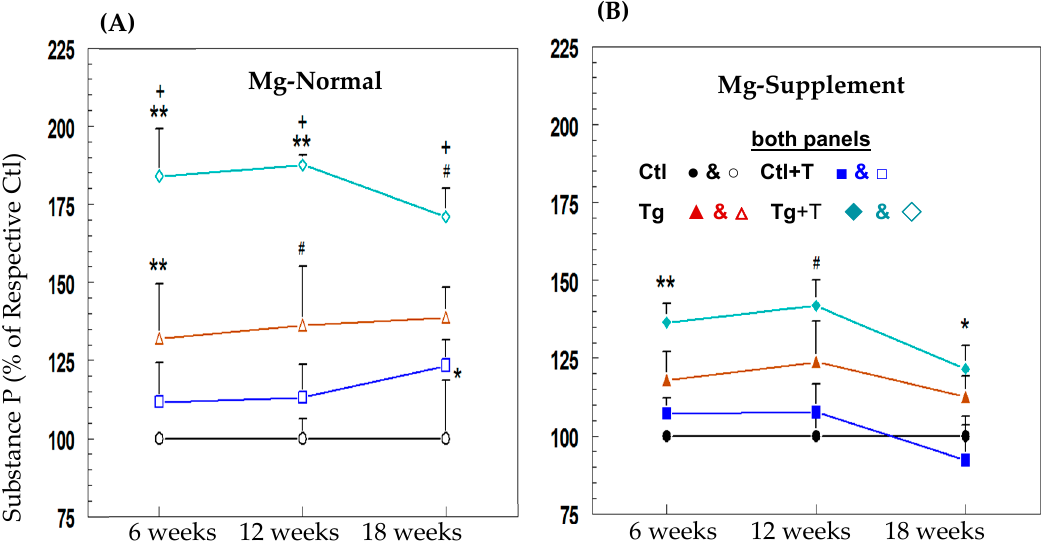
Figure 10. Effects of cART (T) on plasma substance P (SP) level time-courses in control (Ctl) and HIV-1 Tg rats on ( A ) Mg-normal or ( B ) Mg-supplemented diets. SP was assessed by colorimetric ELISA. Values are means ± SE = 5 rats/group for Mg-normal (open symbol) and Mg-supplemented (closed symbol). * p < 0.05, # p < 0.02, ** p < 0.01 vs. respective Ctl (100%); + p < 0.05 vs. Mg normal time-matched Tg counterparts.